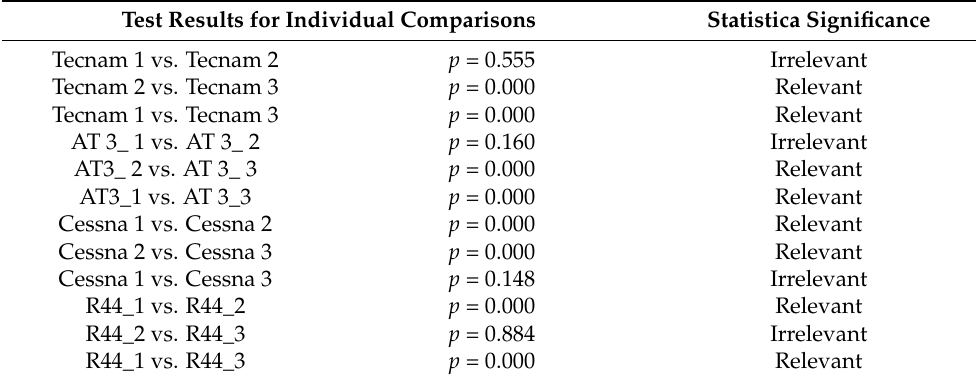
Table 4. Test results for individual comparisons (aircrafts). p —statistical